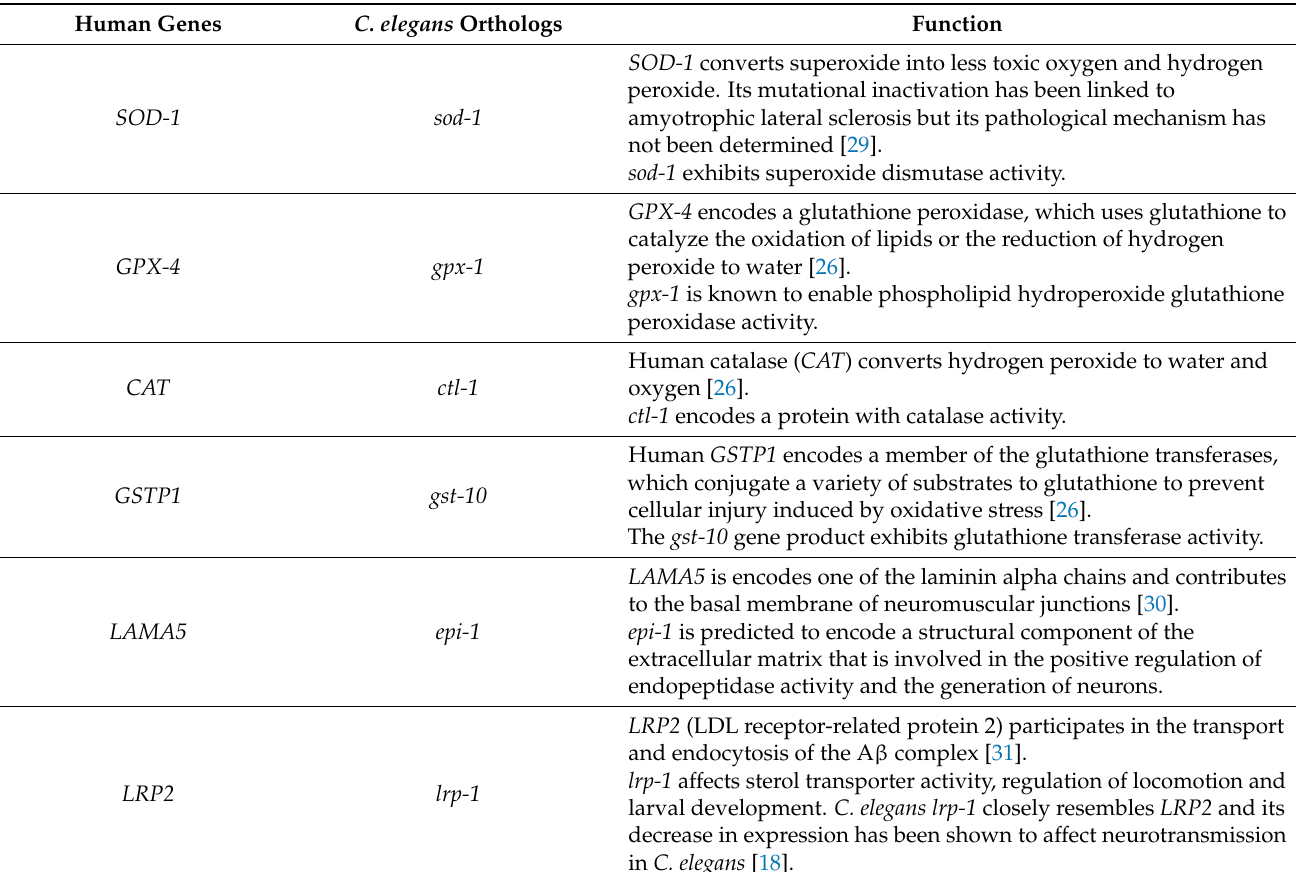
Table 2. Genes selected for this study. The table lists known functions of the human genes and their C. elegans orthologs, along with known biochemical properties of the encoded proteins. Source for C. elegans orthologs’ function: https://www.wormbase.org (accessed on 24 December 2022). Human